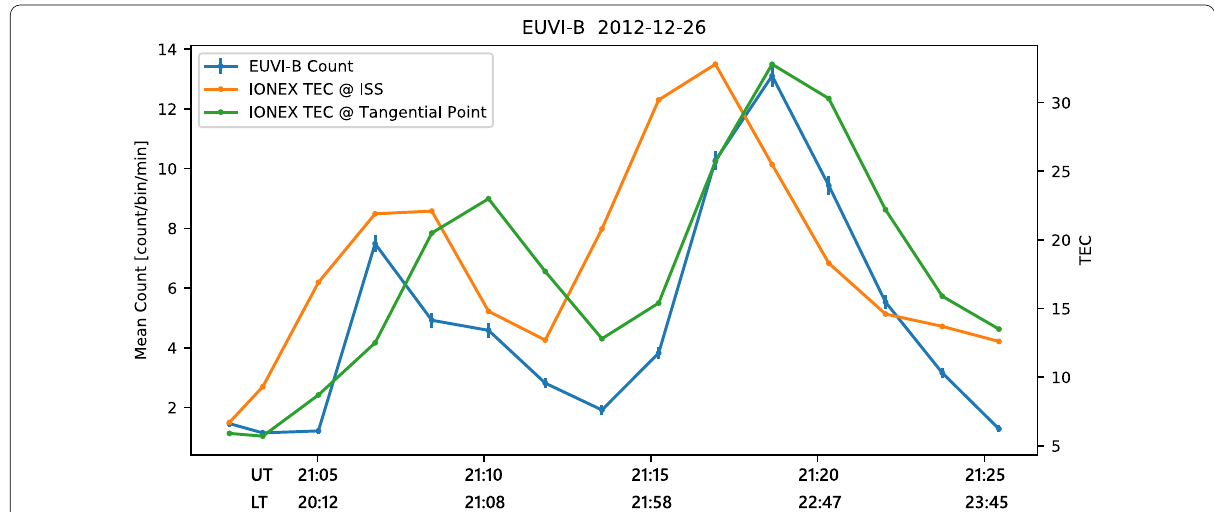
Fig. 3 Time profile of the averaged EUV count over the pixels surrounded by the red square in Fig. 1 (blue) during the period from 21:02 UT to 21:25 UT on December 26, 2012. The total electron content (TEC) value at the ISS location (orange) and that at the tangential point along the line of sight (green) are also plotted for reference. The horizontal axis indicates the universal time (UT) and the local time (LT) at the position of the